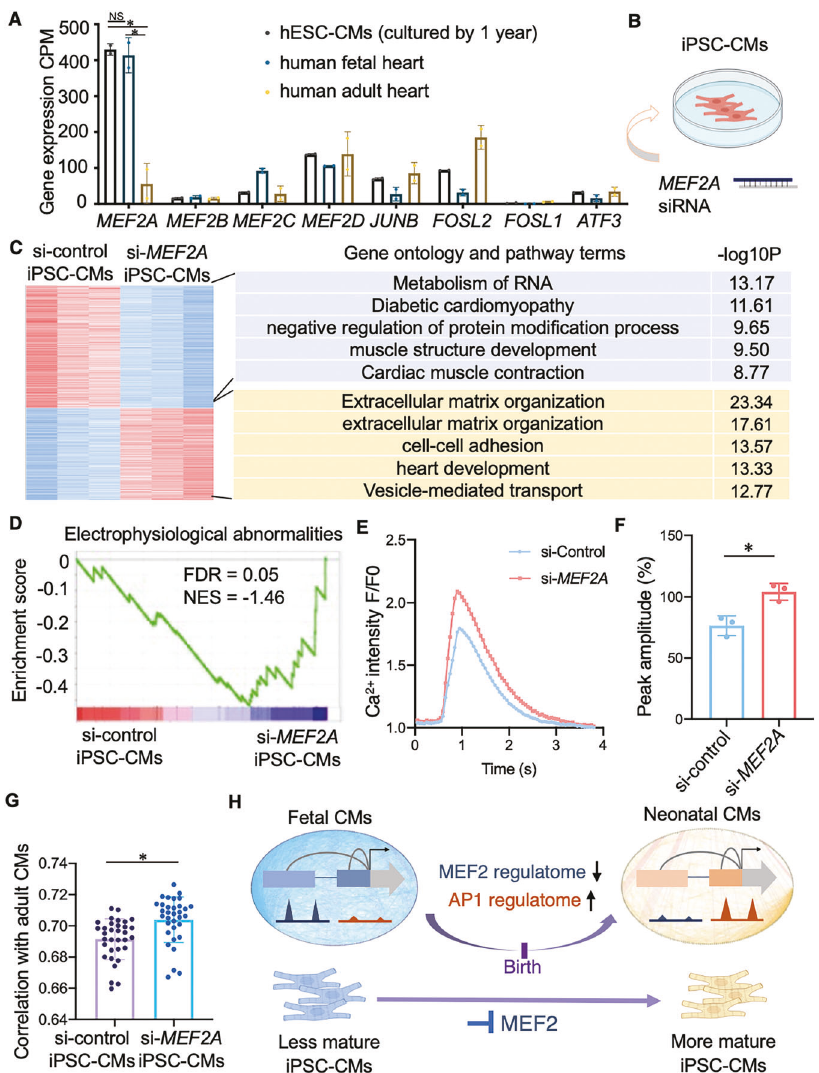
reprogramming in perinatal cardiomyocytes. Key transcription factors, MEF2 and AP1, mediate the remodeling of regulatory program in perinatal CMs. The manipulation of MEF2A would induce the iPSC-CMs more like adult